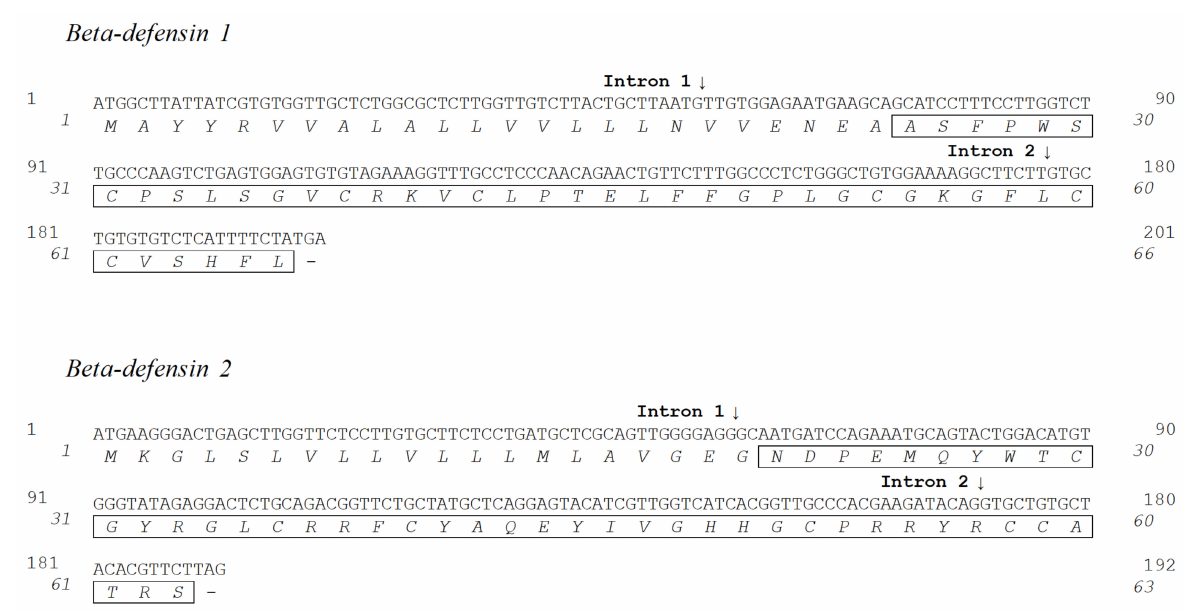
Figure 1. Sea bass beta-defensin coding DNA and amino acid sequences. Nucleotides are indicated in the upper row, and amino acids are indicated in italic in the lower row. Mature peptides are boxed, and intron positions are indicated by arrows.